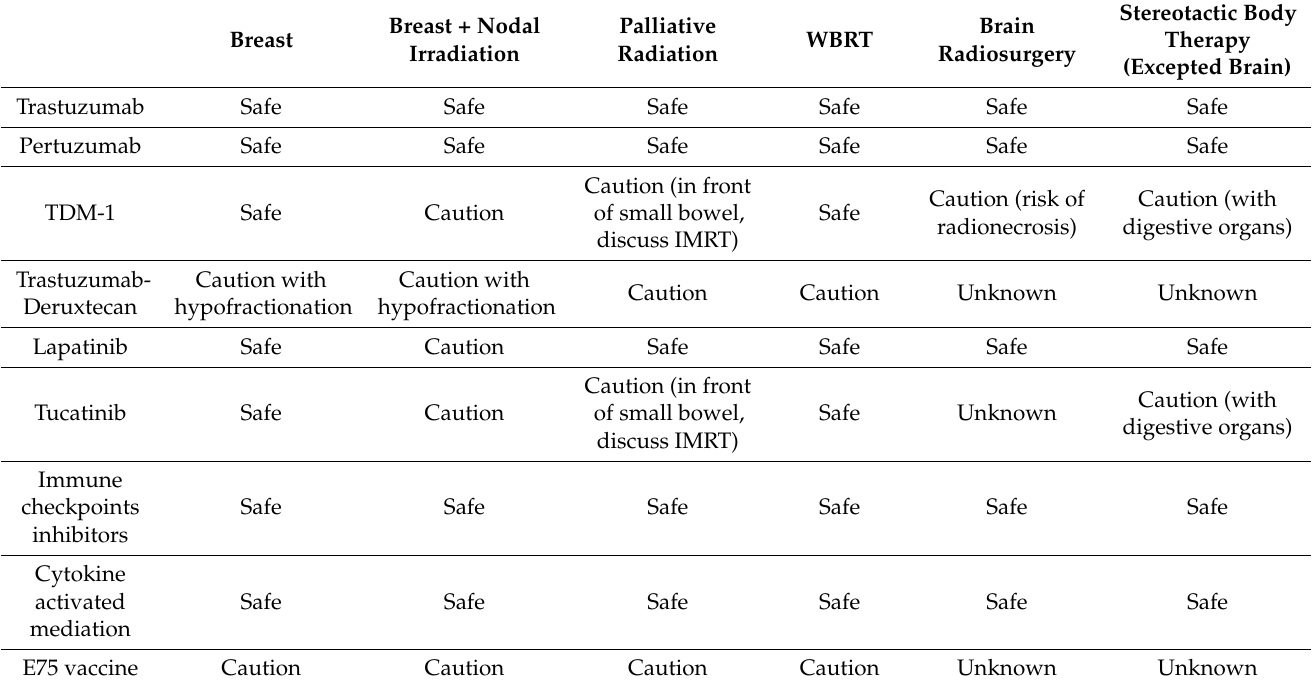
Table 3. Interaction between radiation therapy and targeted therapies in HER2-positive breast cancer: safety and recommendations for clinical